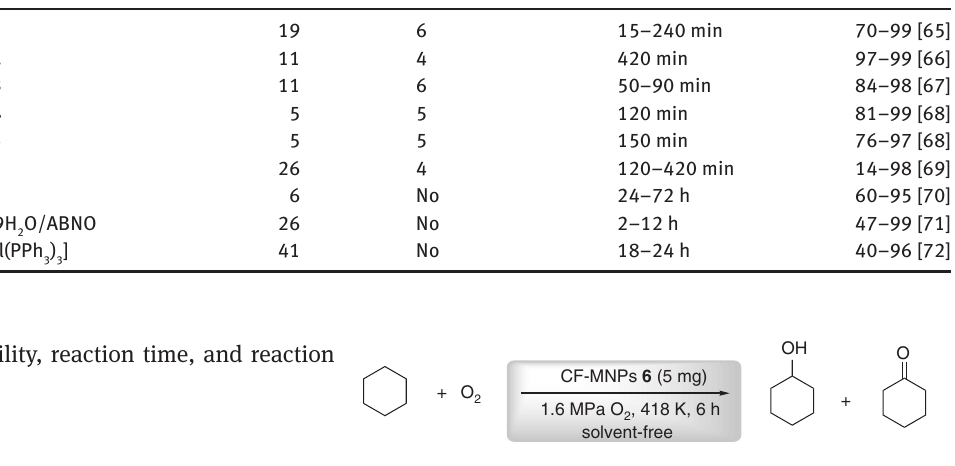
Table 2: Comparison of the activity of CF-MNPs catalysts with other reported catalysts in oxidation of alcohols. Entry